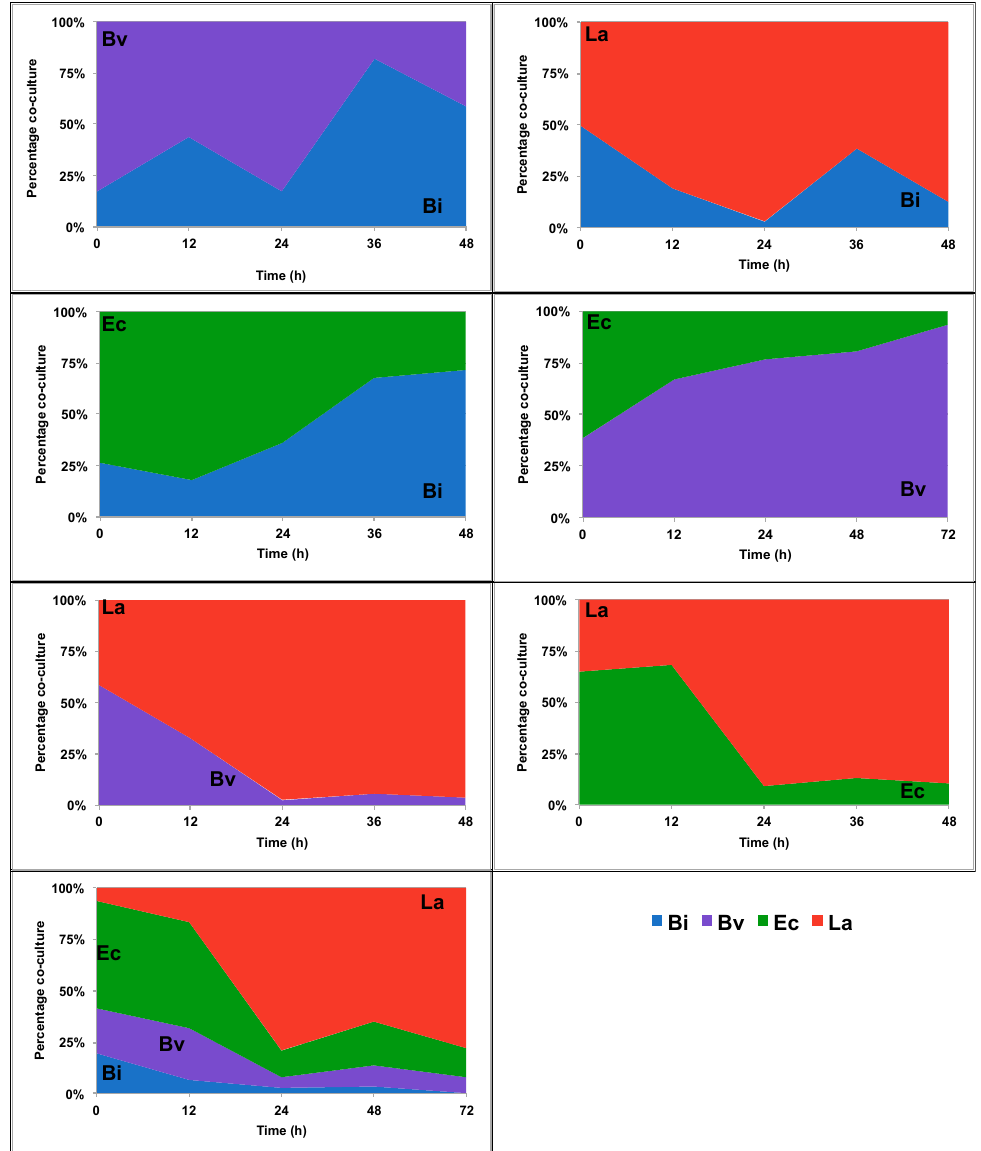
Figure 3. Bacterial abundance in co-culture experiments using fructooligosaccharides (FOS). Co-cultures of Bi ( Bi. infantis ), Ba ( Ba. vulgatus ), Ec ( E. coli ) and La ( L. acidophilus ) were grown as shown in the legend. Cell copy numbers were determined every 12 h. Percentages represent the proportion of the cell copies for each bacterium in each combination.